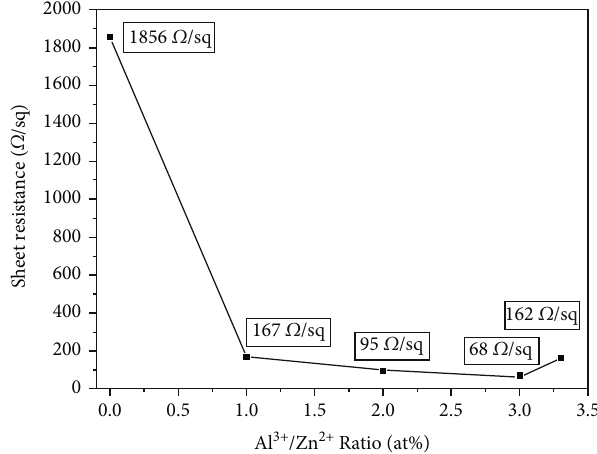
Figure 8: Sheet resistance of pure and Al-doped ZnO samples as a function of Al 3+ /Zn 2+ ratio in the precursors.